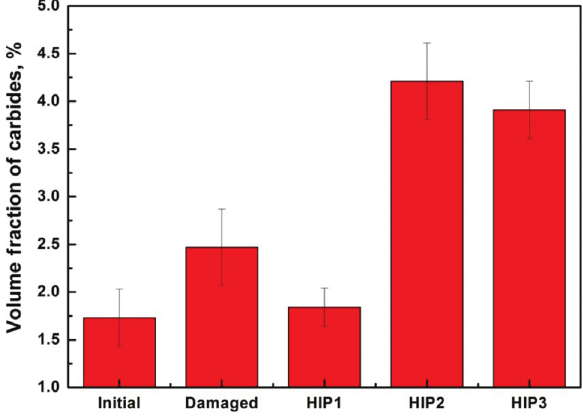
Figure 8: Changes of volume fraction of carbides for K002 superalloy under different HIP conditions.